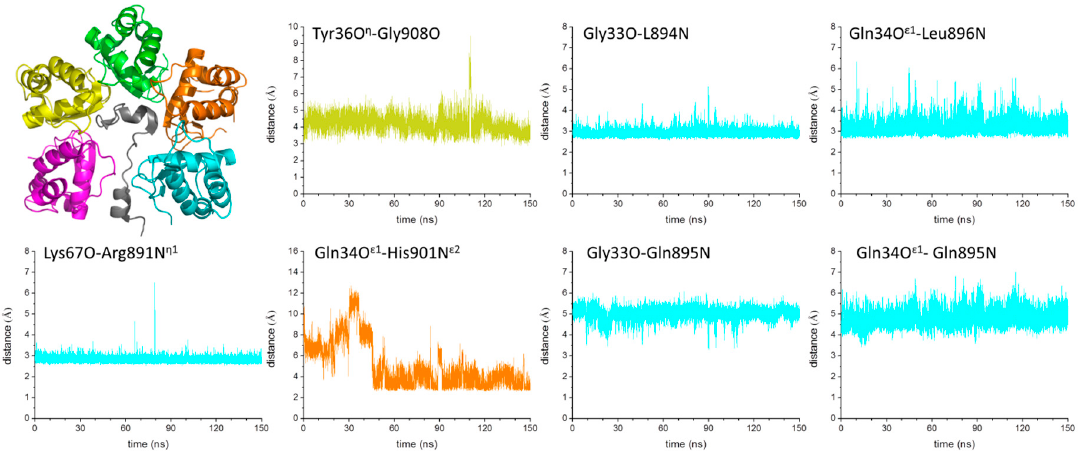
Figure 7. Cartoon representation of the crystal structure of the complex between KCTD16 BTB and GABA B2 R peptide (PDB ID: 6M8R) used as starting model in the MD simulation. Time evolution of the distances between pairs of atoms involved in the formation of H-bonding interactions in the complex. The H-bonds between atoms Tyr36O η -Gly908O, Gly33O-L894N, Gln34O ε 1 -Leu896N, and Lys67O-Arg891N η 1 that are present in the starting crystallographic model are conserved throughout the simulation. The H-bonds between atoms Gln34 O ε 1 -His901 N ε 2 , Gly33 O -Gln895 N , and Gln34 O ε 1 -Gln895 N that are not present in the starting structure but are present in the structure of the complex between KCTD16 BTB and the GABA B2 R peptide encompassing residues 895-909 are formed in the simulation. Plots are colored to identify the chains of KCTD16 BTB that interact with the peptide (in grey).